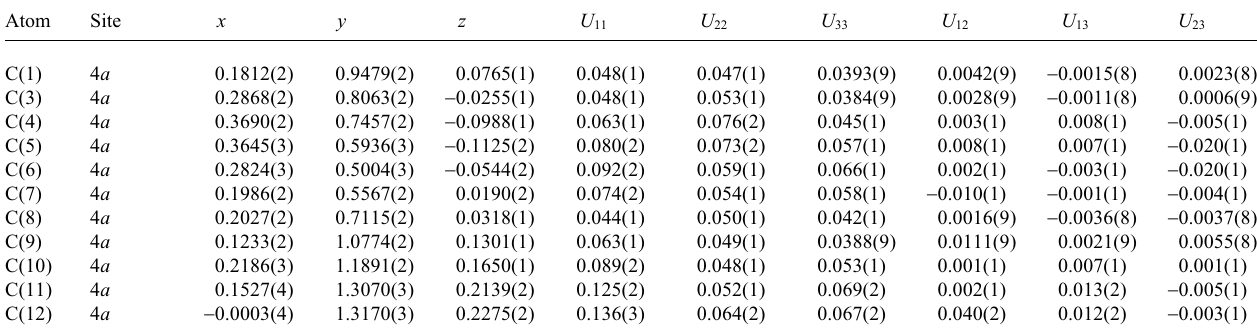
Table 3. Atomic coordinates and displacement parameters (in Å 2